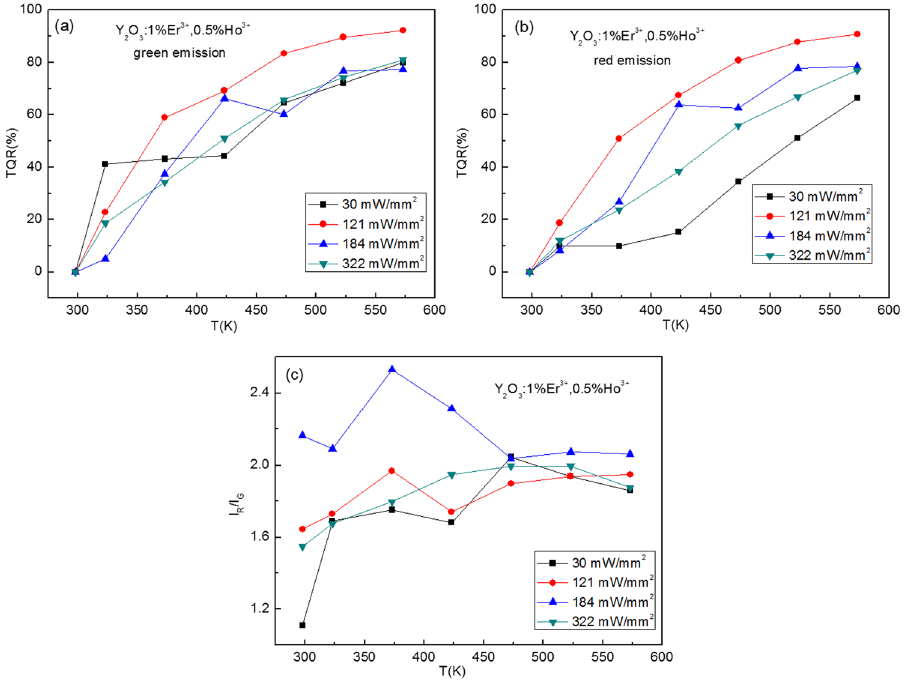
Figure 12. Excitation powers dependent TRQ of ( a ) green and ( b ) red emissions of Y 2 O 3 :1%Er 3 + , 0.5%Ho 3 + , and ( c ) red to green intensity ratio of Y 2 O 3 :1%Er 3 + , 0.5%Ho 3 + .